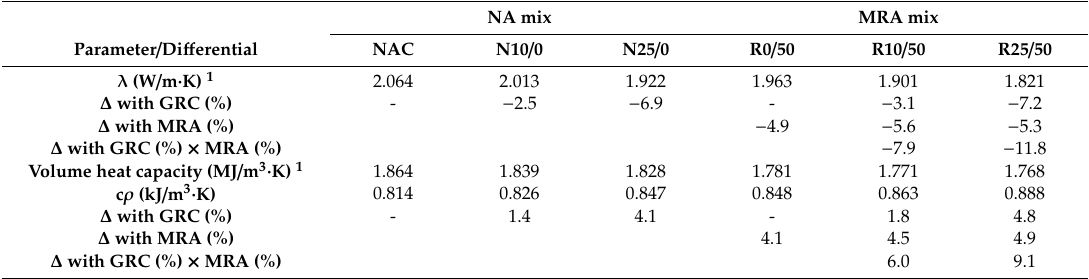
Figure 5. Open porosity versus electrical conductivity.